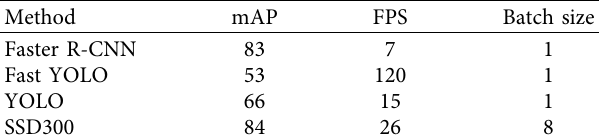
Table 1: Comparison results of SSD and other detection algorithms.